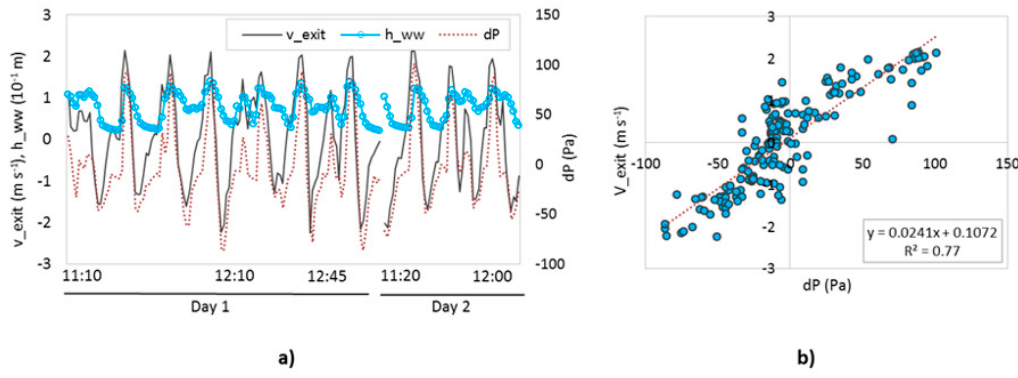
Figure 2. Variation of pressure differences between manhole invert and ambient atmosphere and air velocity at the venting stack: ( a ) over time during two consecutive days, and ( b ) ordinary least squares (OLS) regression between both variables.